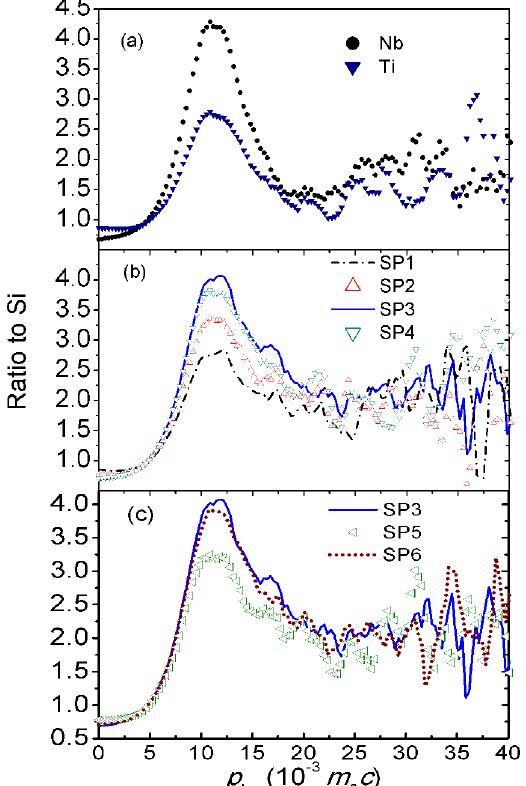
Figure 4. The ratio curves for the samples; (a) Nb and Ti ratio curves; (b) The SP1, SP2, SP3 and SP4 ratio curves, (c) The SP3,